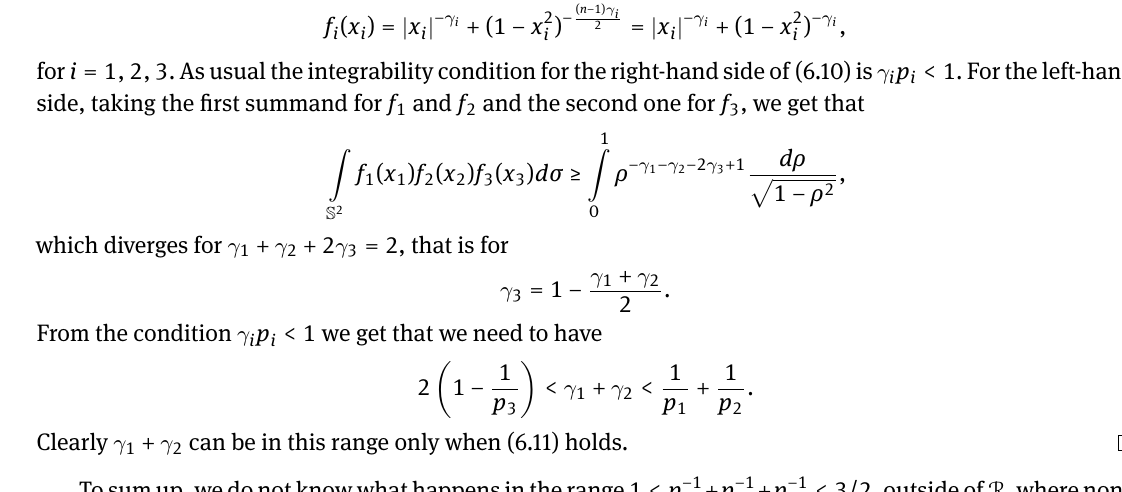
+ p −1 + p −1 < 3/2. In this range we have the 1 2 3